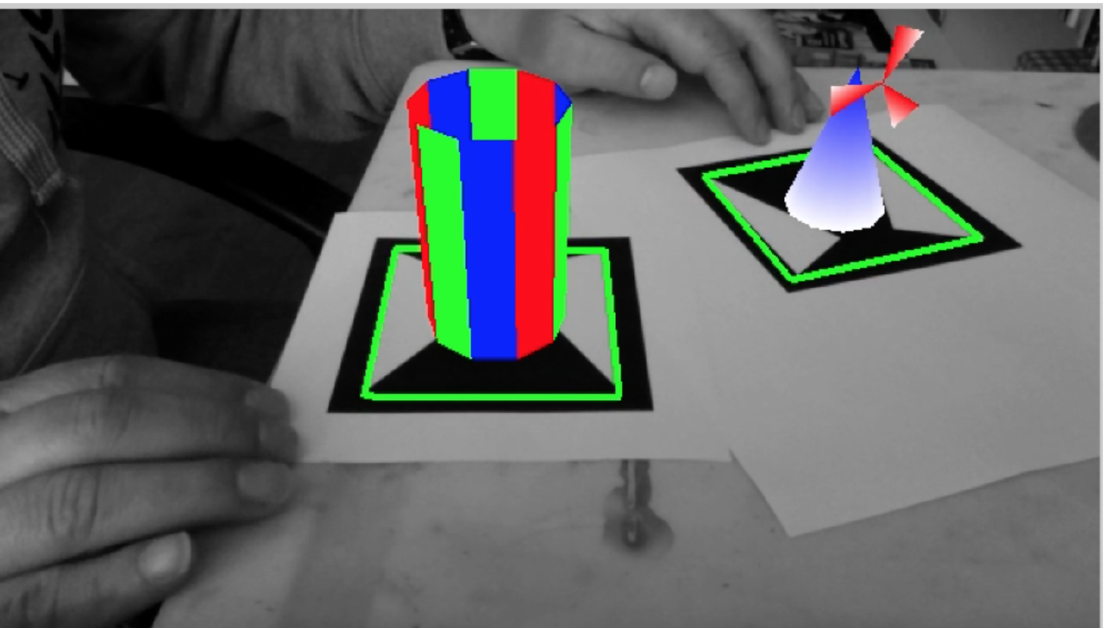
Figure 10. A picture of an augmented reality application that shows two virtual objects drawn above the optimized markers C 6 and C 6 . These markers are also shown at the right of Figure 5 9